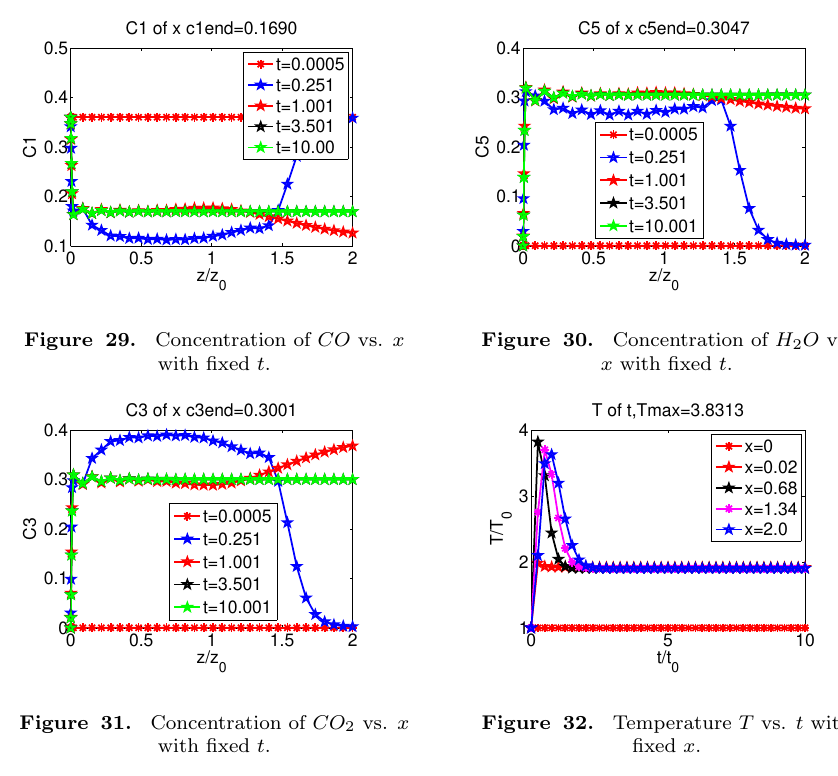
Figure 31. Concentration of CO 2 vs. x with fixed t .